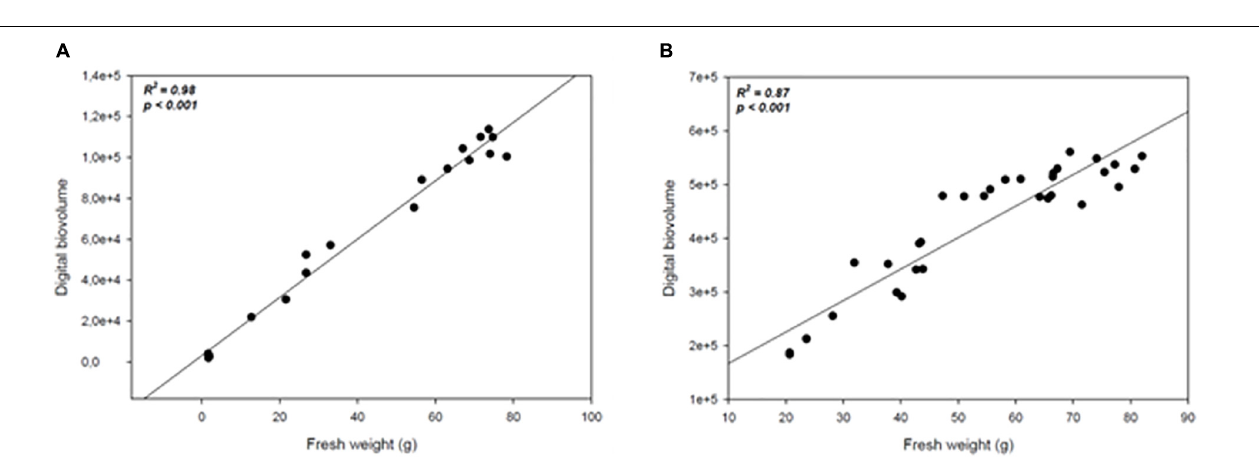
FIGURE 7 | Water use efficiency mean values of tomato plants exposed to different watering conditions: UTC(70) refers to the Untreated Control thesis where plants were irrigated with 70% FC, indicated with a dashed line. Tomato plants under reduced water condition (70% FC) and treated with the biostimulant prototypes are indicated with the solid line.